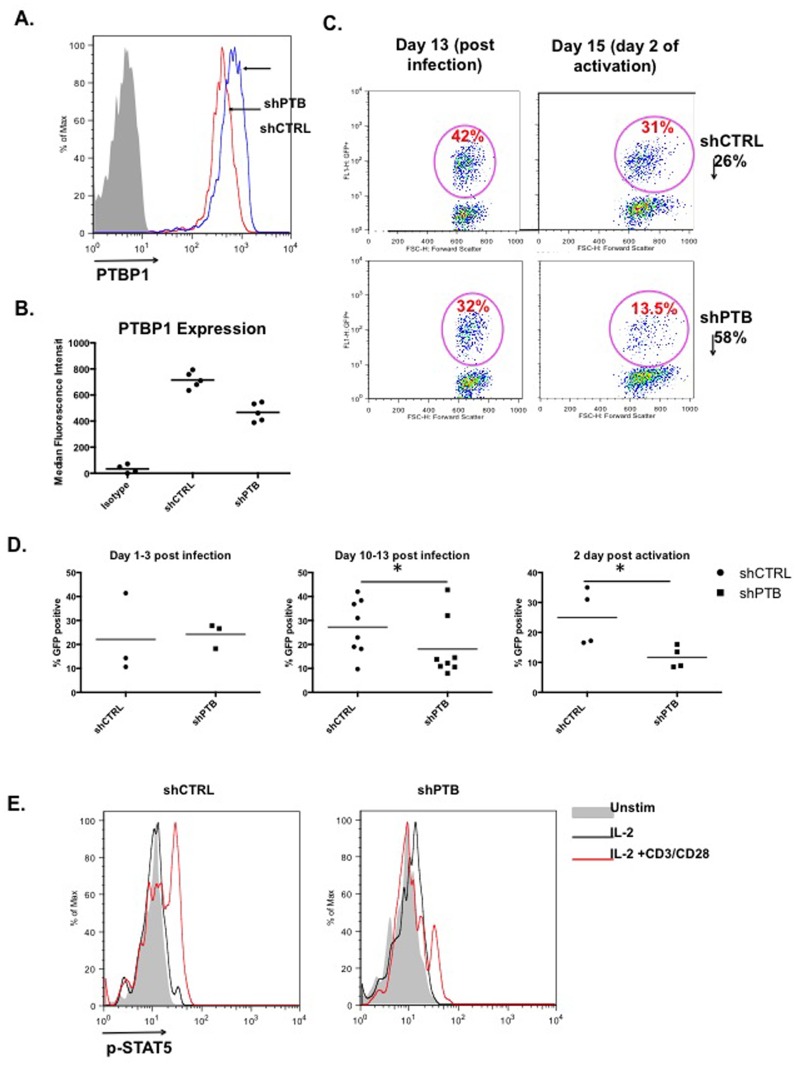
PTBP1 is required for optimal expansion of CD4 T cells.(A) Negatively selected CD4 T cells were infected with either pLV-shCTRL or pLV-shPTB lentivirus, expanded for 10 days in IL-2 and removed from IL-2 for one day. At day 11, GFPposCD4pos cells were analyzed for PTBP1 expression using intracellular immunostaining with anti-PTBP1 mAb or isotype control. Median fluorescence intensity (MFI) of 5 independent experiments is indicated in table below. (B) CD4 T cells infected with either pLV-shCTRL or pLV-shPTB were expanded for 13 days and activated for two days with anti-CD3 + anti-CD28 antibodies. The GFPpos population in each panel is presented as a percentage of the total CD4pos population. (C) Experiments were carried out as in “B” and data compiled from a minimum of three independent experiments. Comparisons between pLV-shCTRL or pLV-shPTB infected cultures were carried out at 1–3 and 10–13 days post infection and again 2 days post activation. (D) Analysis of phospho-STAT5 after a 10 day IL-2-dependent expansion, followed by either 2 days with no IL-2 (grey bar), or 1 day with no IL-2 and either a 20 min stimulation with 250 U of IL-2 (black line) or 250 U IL-2 plus anti-CD3 + anti-CD28 beads (red line).